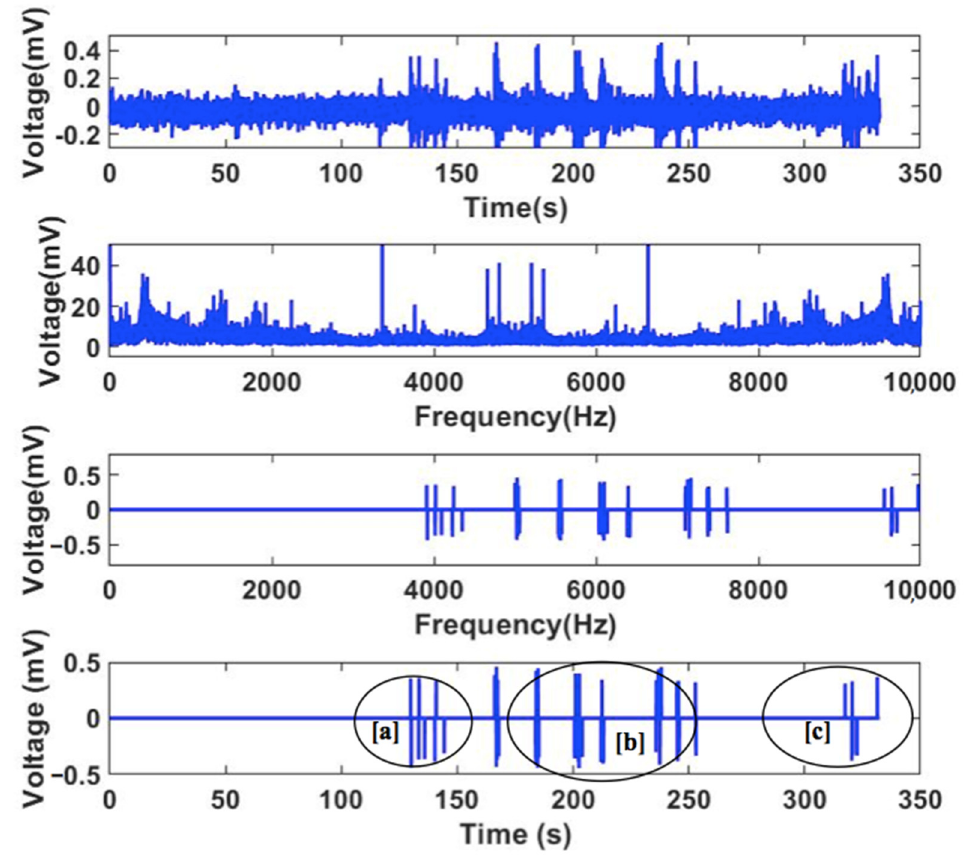
Figure 15. GFRP-MWCNT electromagnetic emitted voltage during mechanical loading and noise filter electromagnetic emitted voltage during mechanical loading where the slight charge release is labeled as [a]; upon further loading, crack propagates and more charge release was observed at both sections [b] and [c].